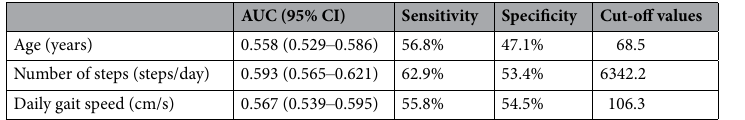
Table 2. Diagnostic values of age and gait parameters for screening prefrailty. AUC = Area under the curve, CI = confidence